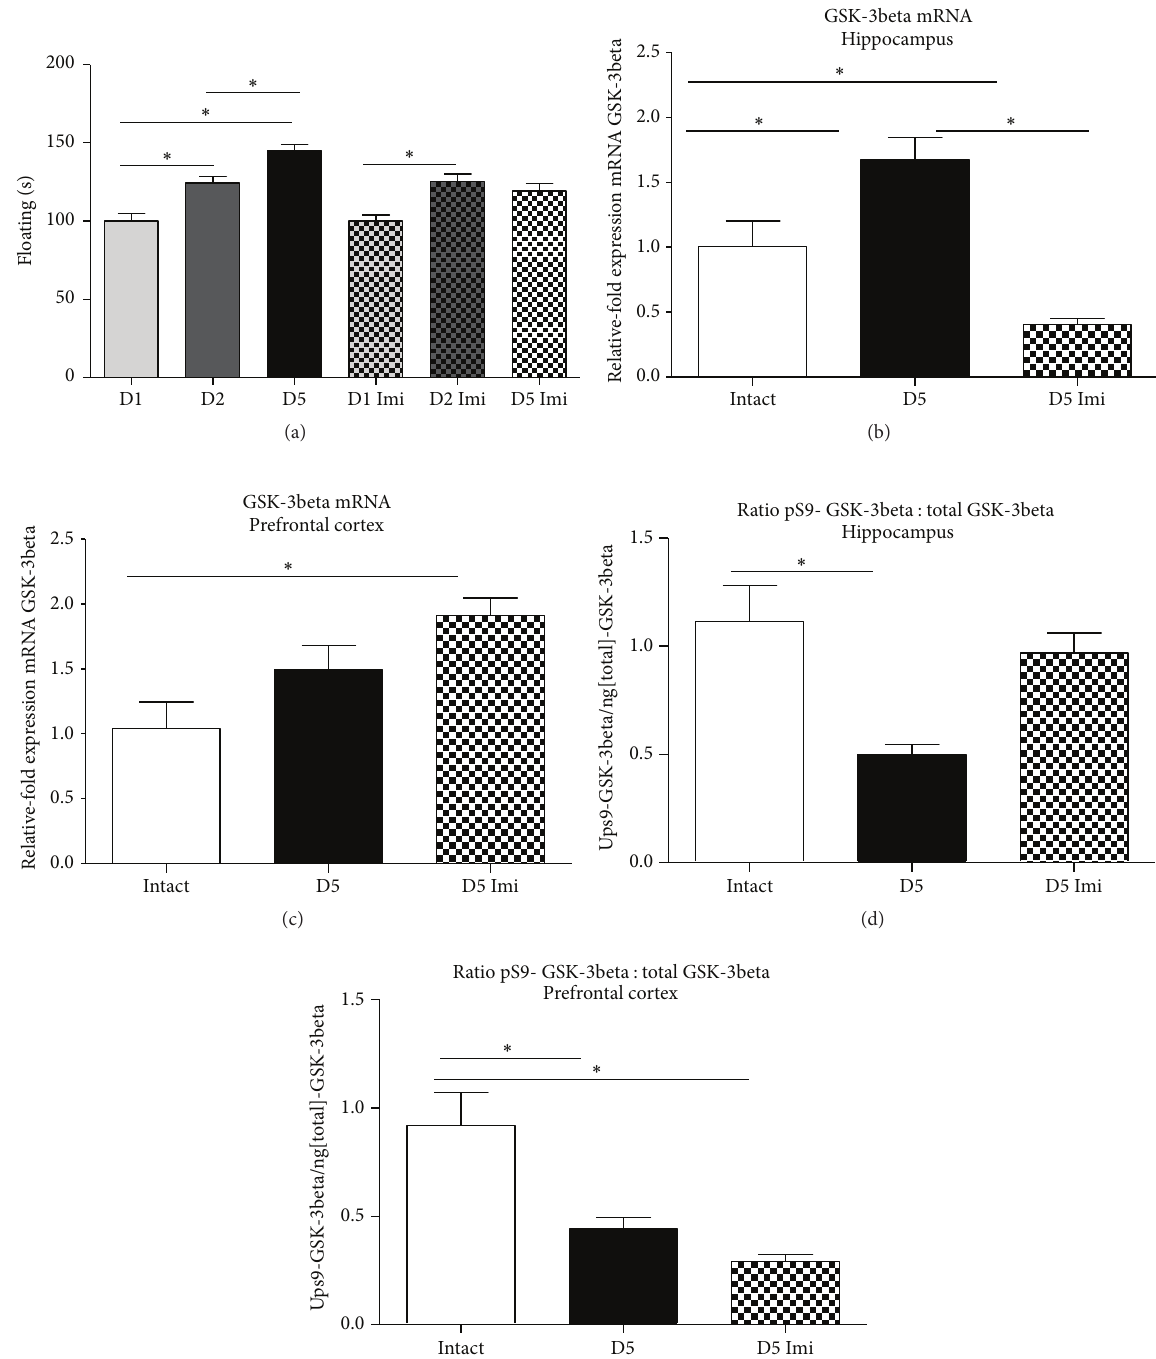
Figure 6: The effects of imipramine on floating behaviour and brain GSK-3beta activities in the modified swim test. (a) Imipramine-treated mice ( 𝑛 = 14 ) showed no significant increase of floating behaviour as compared with control group ( 𝑛 = 14 ), from Day 2 to Day 5. As compared to intact controls ( 𝑛 = 13 ), on Day 5, GSK-3beta mRNA of imipramine-treated mice was (b) decreased in the hippocampus and ( c ) not changed in the prefrontal cortex; group sizes as indicated above. (d) As compared to intact mice, imipramine-treated group had significantly increased ratio of total/pS9 of GSK-3beta in the hippocampus on Day 5; group sizes as indicated above. (e) As compared with intact mice, there were no significant changes the in ratio of pS9 GSK-3beta /total GSK-3beta in the prefrontal cortex of imipramine-treated mice on Day 5 of swim test; group sizes as indicated above. ∗ 𝑝 < 0.05 , ANOVA and Tukey’s multiple comparisons test; see the text; Imi: imipramine-treated group; D1: Day 1; D2: Day 2; D5: Day 5. Data are mean ±